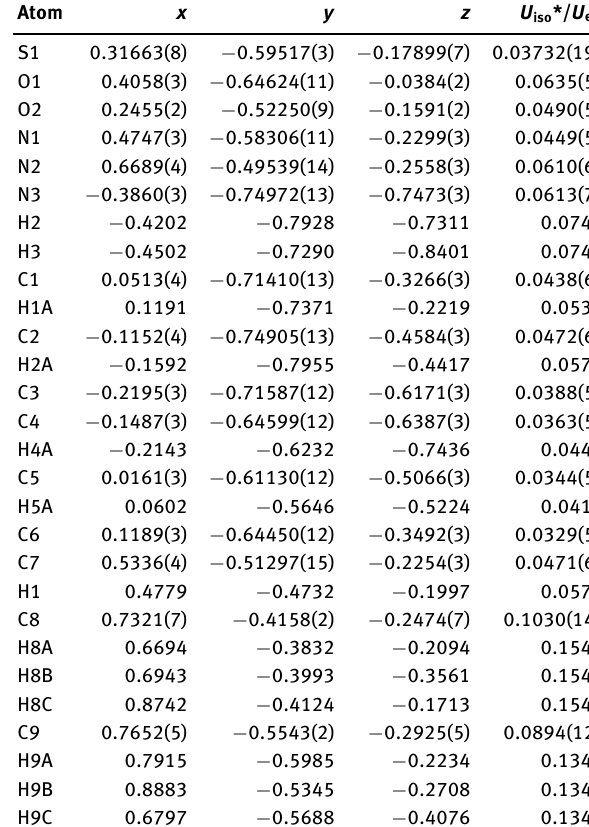
Table 2: Fractional atomic coordinates and isotropic or